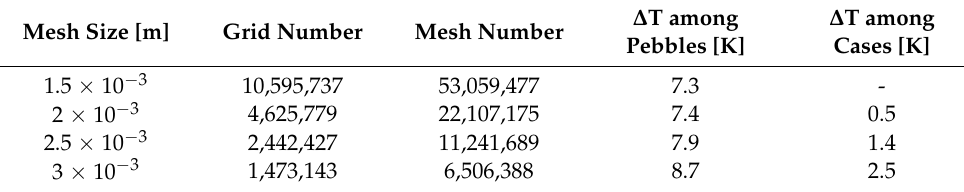
Table 2. Elements’ sizes and temperature